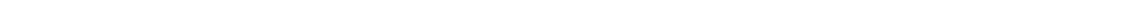
Fig. 1 Dependencies of Stu1 and Slk19 localization and sequestering to uaKTs. a Domain structure and function of Stu1 8 . b – m Genotypes of the strains revealing the fl uorescent fusion proteins are listed in Supplementary Table 1. The percentage of cells revealing the depicted phenotype is indicated. Statistics see Supplementary Table 3. Bars, 2 µ m. b – l Cells with the indicated genetic background were analyzed 3 – 4 h after the release from G1 into nocodazole. White arrowheads indicate uaKTs. b Stu1 is sequestered at uaKTs 6 . c Slk19 accumulates at uaKTs. d The accumulation of Slk19 at uaKTs depends on Stu1., Δ stu1 ’ indicates that Stu1 was depleted. e The sequestering of Stu1 at uaKTs depends on Slk19. f The CL domain of Stu1 is required for Stu1 sequestering 8 . g The CL domain of Stu1 is required for the accumulation of Slk19. h Stu1 Δ TOGL1 Δ D4 can localize to uaKTs in the presence of WT Stu1. i Stu1 Δ TOGL1 Δ CL Δ D4 cannot localize to uaKTs even in the presence of WT Stu1. j The localization of Stu1 depends on Mps1. 1NM-PP1 was added after the G1 release. k Sequestering of Slk19 but not the basal localization of Slk19 depends on Mps1. Cells were treated as in j . l Mutating the six MELT Mps1 phosphorylation sites in Spc105 19 to alanine ( spc105-6A ) prevents Stu1 sequestering. WT Spc105 in the background was depleted during the G1 arrest and Cdc20 was depleted with the G1 release to prevent the SAC-de fi cient cells from progressing into anaphase. m Stu1 Δ ML is sequestered at attached KTs when Mps1 is localized to Spc105 ectopically. Cells were arrested in metaphase by Cdc20 depletion and rapamycin was added as indicated. WT Stu1 was present in the background. n Model depicting the sequestering of Stu1 at uaKTs. In the absence of KT-MT interaction, Ndc80c-localized Mps1 phosphorylates Spc105 and thus prompts Stu1 localization to uaKTs. A putative conformational change that involves the CL domain triggers the interaction of Stu1 and Slk19. Propagated conformational changes in Slk19 and Stu1 lead to co-polymerization. Stu1 Δ TOGL1 Δ D4, which is unable to bind to uaKTs alone 8 , can bind to the Slk19 endpoints of the polymer, whereas Stu1 Δ TOGL1 Δ D4 Δ CL cannot (see h and i